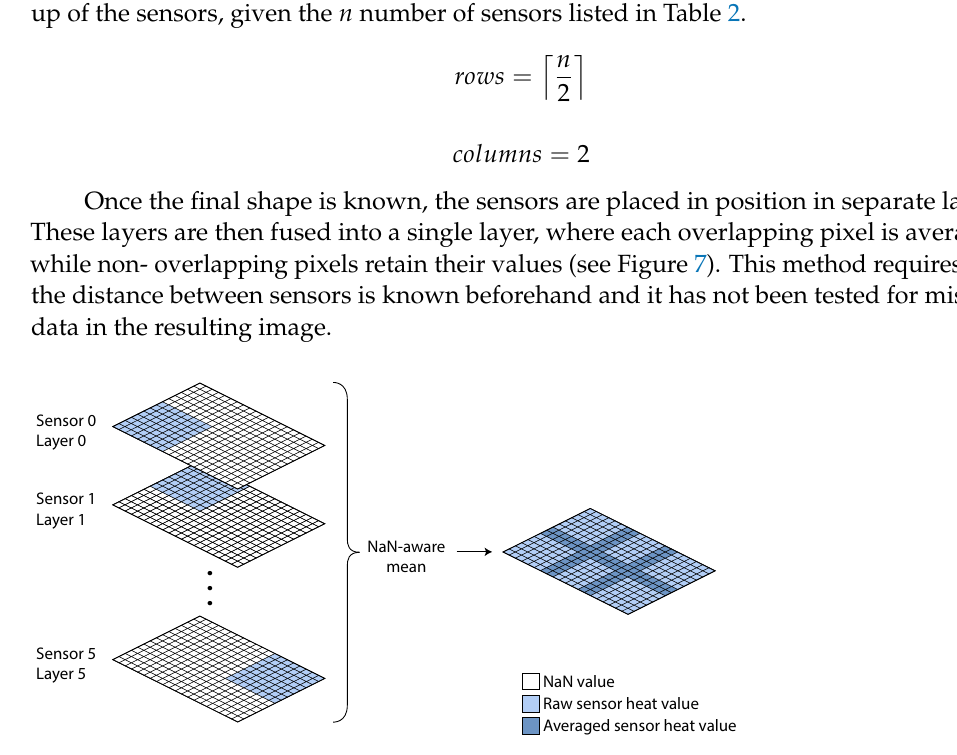
Figure 7. An example of sensor fusion for Data 4